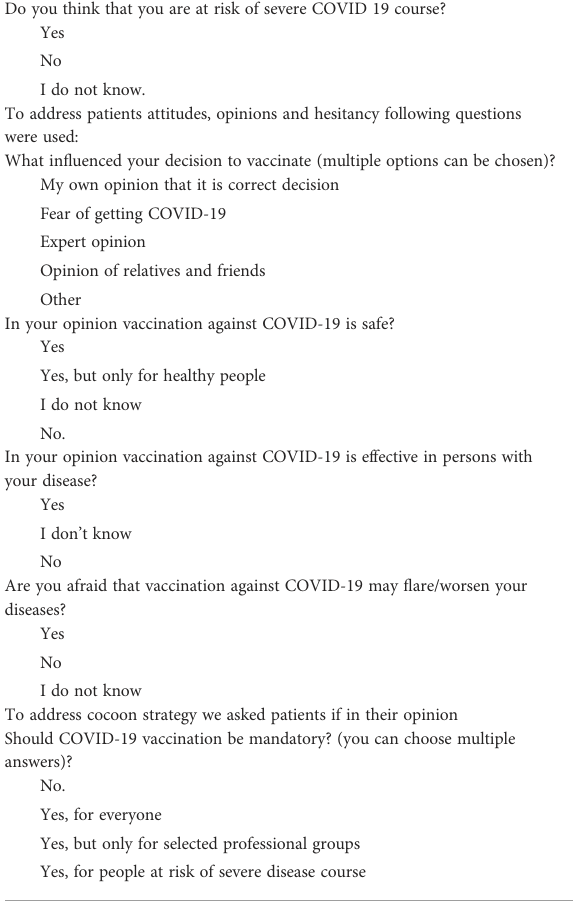
(Table 2), but their disease perception did; patients with AIIRDs anticipated the worst effects of the disease on their lives. Table 3 presents the Brief Illness Perception Questionnaire results and comparisons.